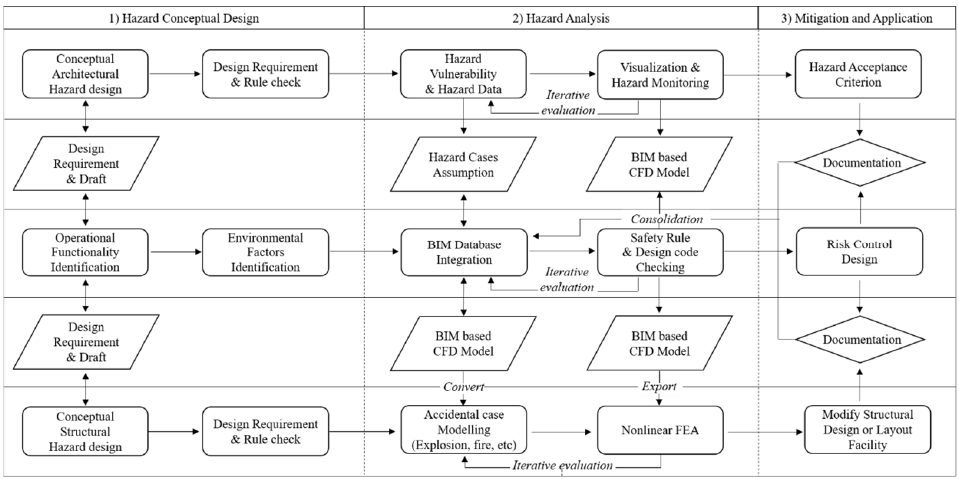
Figure 6. The flowchart for integrating the BIM data platform and CFD design packages for a comprehensive hazard analysis.